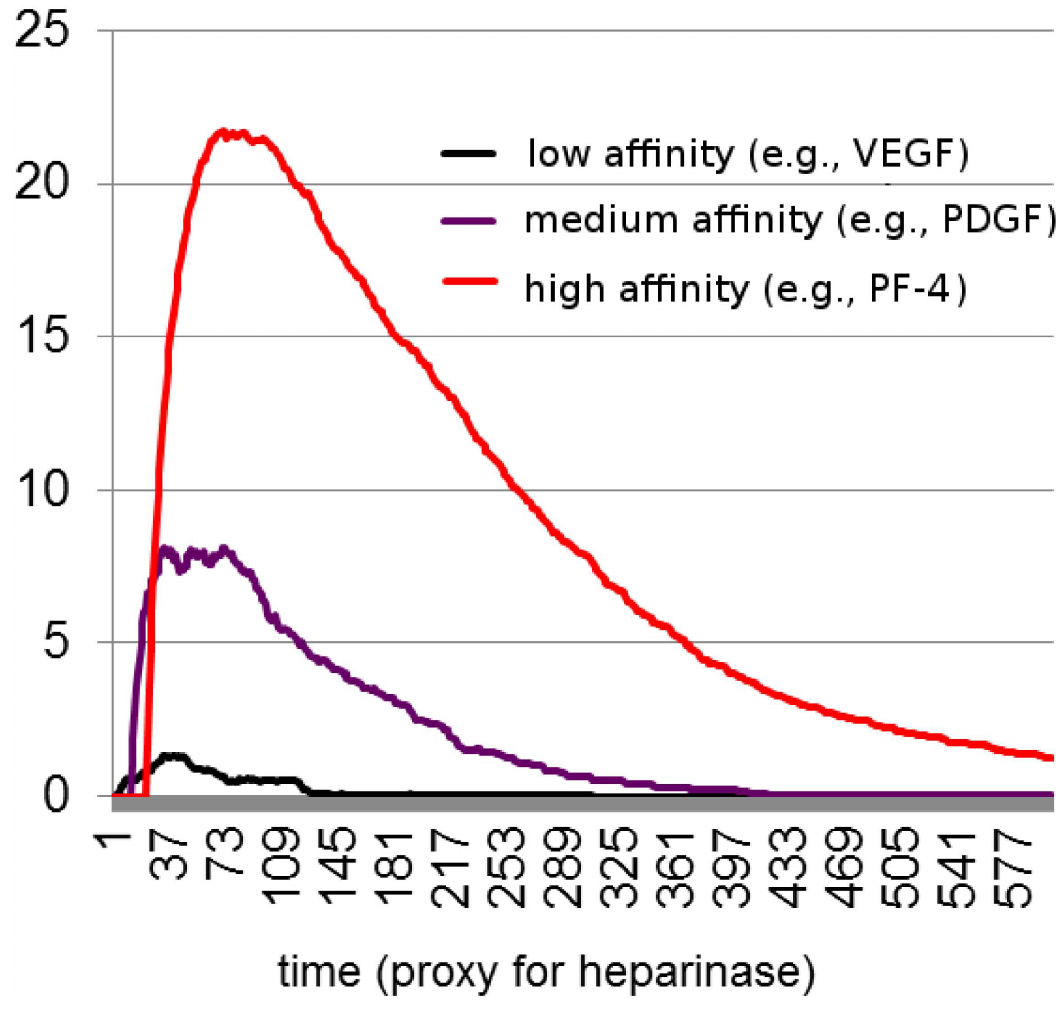
Fig 3. Simulation of cytokine releaseduring normal wound healing. Angiogenesisregulators bound to a heparin sulfate moiety in platelet clots are eluted using incremental concentrations of sodium chlorideas a surrogate for tissue proteases. The experimentally observedrelease of growth factors appears to suggest that angiogenesis regulatorsare released in order of their affinity for heparansulfate, with VEGF havingthe lowest affinity, and PF-4 and TSP-1 the